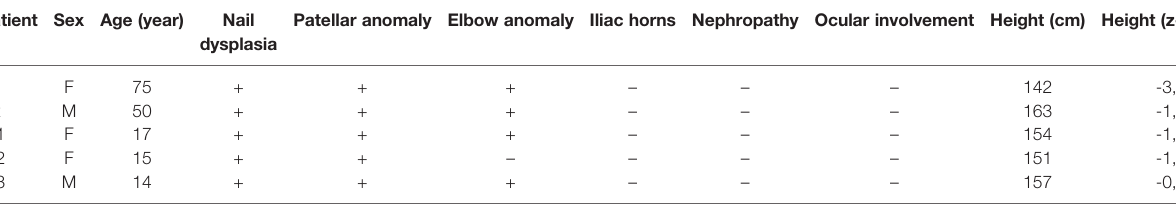
*Z-score is calculated by WHO child growth standards